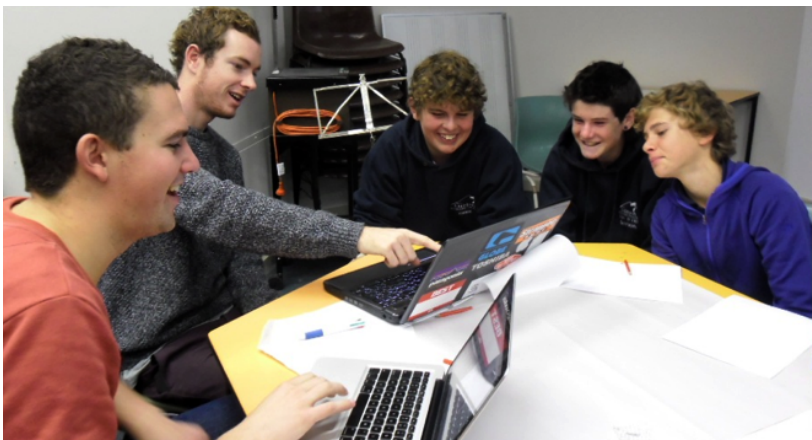
Figure 4. School students visit the university for the project. (Image by Marion Drummond, 2012). lives too… (CL, female postgraduate, Mediterranean heritage,